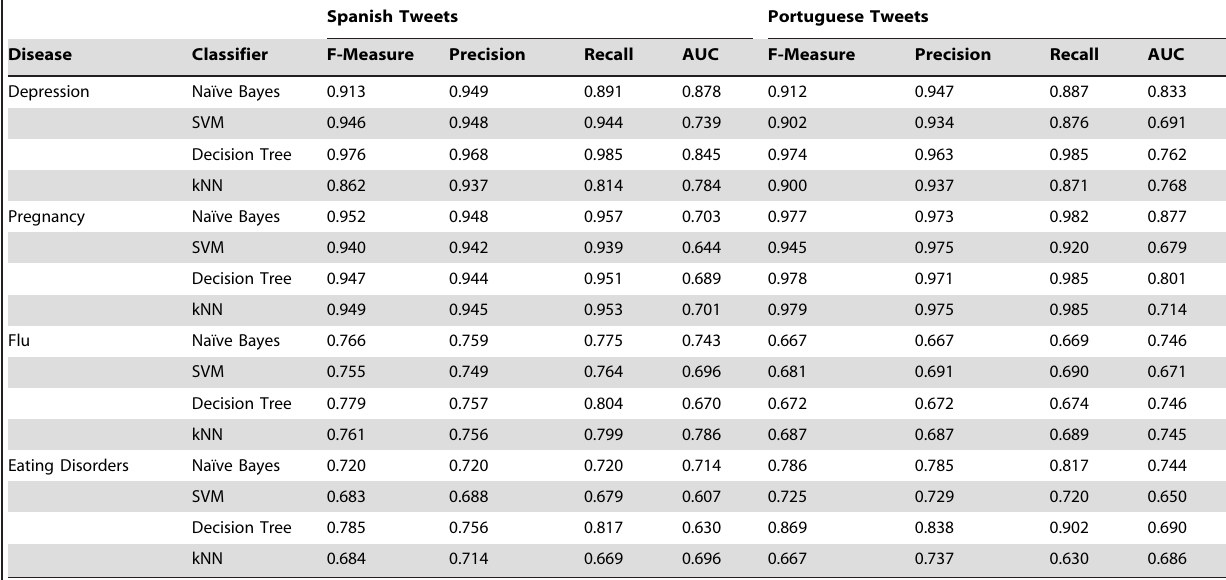
Table 5. Results obtained on the datasets.